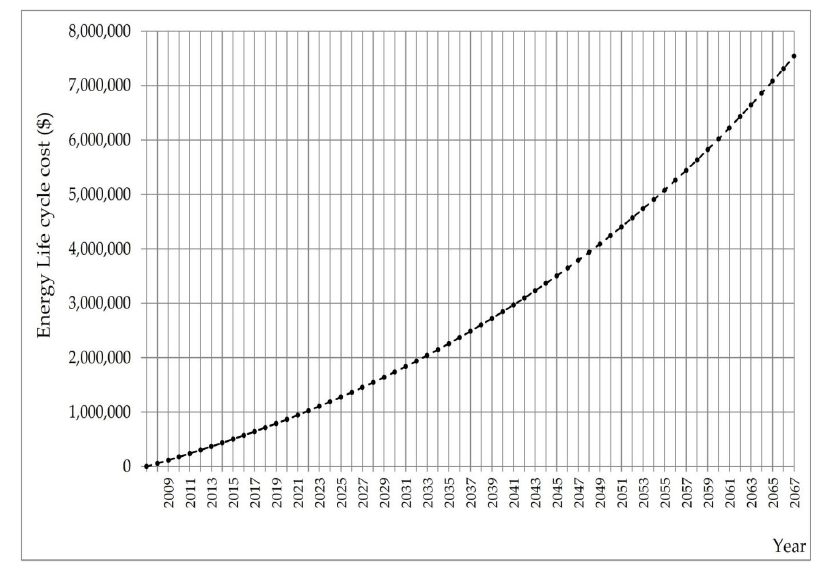
Figure 4. Graphic representation of energy life cycle cost baseline.